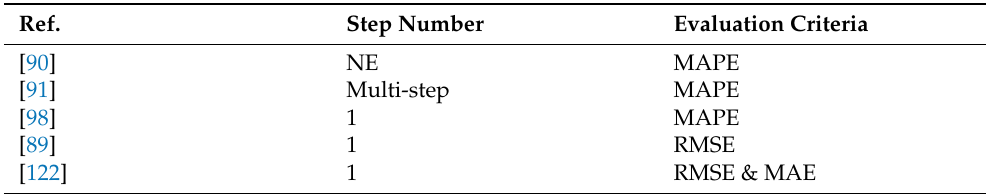
Table 5. Studies carried out with a long-term prediction horizon. Ref. Step